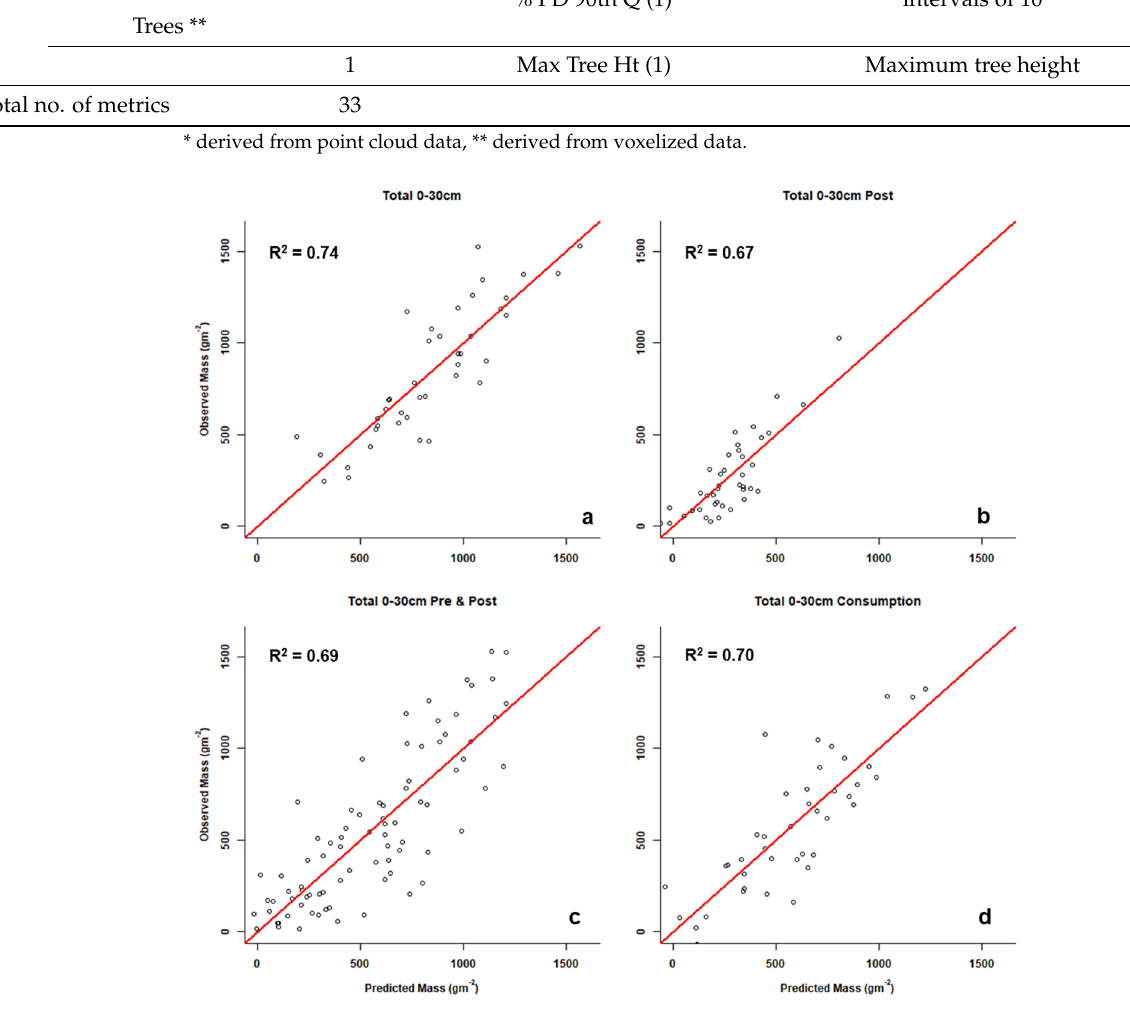
Figure 3. Observed vs. predicted surface biomass for the Total 0–30 cm vegetation and fuel mass class, using the pre-burn (( a ), n = 41), post-burn (( b ), n = 41), pre- and post-burn combined ( c ), ( n = 82), and consumption (( d ), n = 41) linear